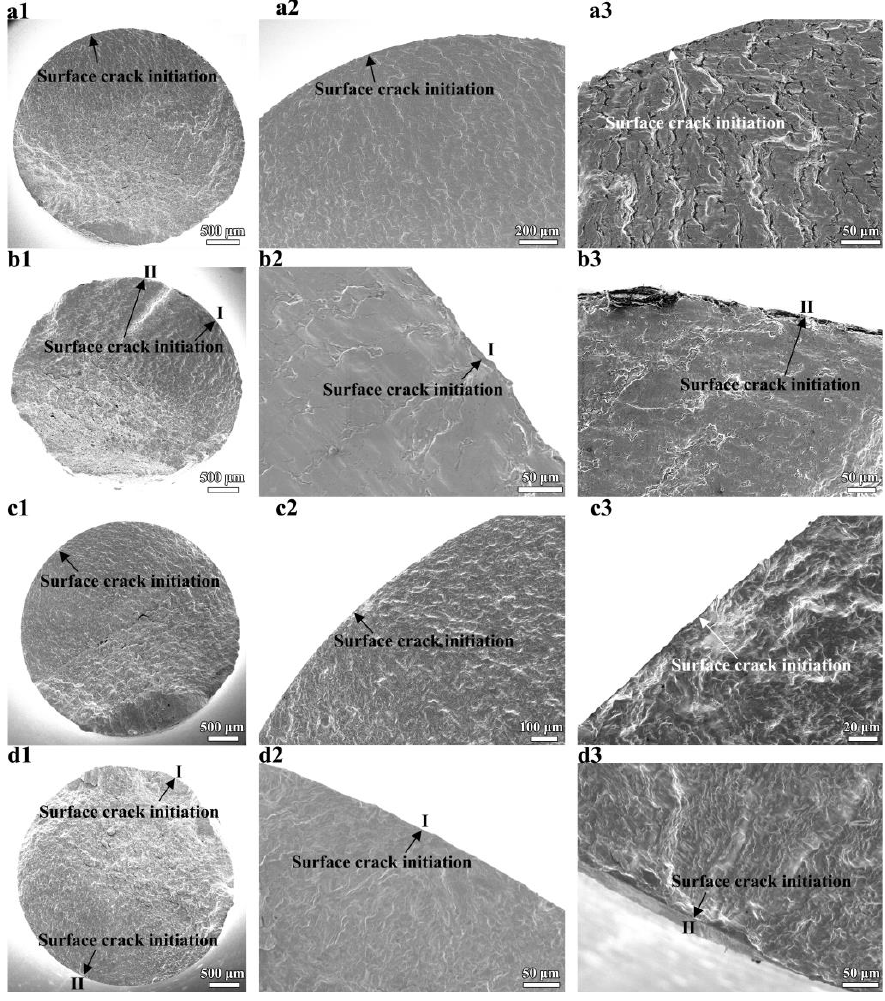
Figure 4. Fatigue fracture surfaces of 25CrMo4 specimens in the initial state and after NA-26000. ( a1 – a3 ) Initial specimen failed from single-site crack initiation: 𝜎 𝑎 = 330 MPa, N f = 8.9 × 10 5 cycles; ( a2 , a3 ) are enlarged views of the crack initiation site. ( b1 – b3 ) Initial specimen failed from multi-site crack initiation: 𝜎 𝑎 = 330 MPa, N f = 2.0 × 10 5 cycles; ( b2 , b3 ) are enlarged views of the two crack initiation sites. ( c1 – c3 ) Specimen after NA-26000 failed from single-site crack initiation: 𝜎 𝑎 = 330 MPa, N f = 2.9 × 10 5 cycles; ( c2 , c3 ) are enlarged views of the crack initiation site. ( d1 – d3 ) Specimen after NA-26000 failed from multi-site crack initiation: 𝜎 𝑎 = 330 MPa, N f = 1.2 × 10 6 cycles; ( d2 , d3 ) are enlarged views of the two crack initiation sites.